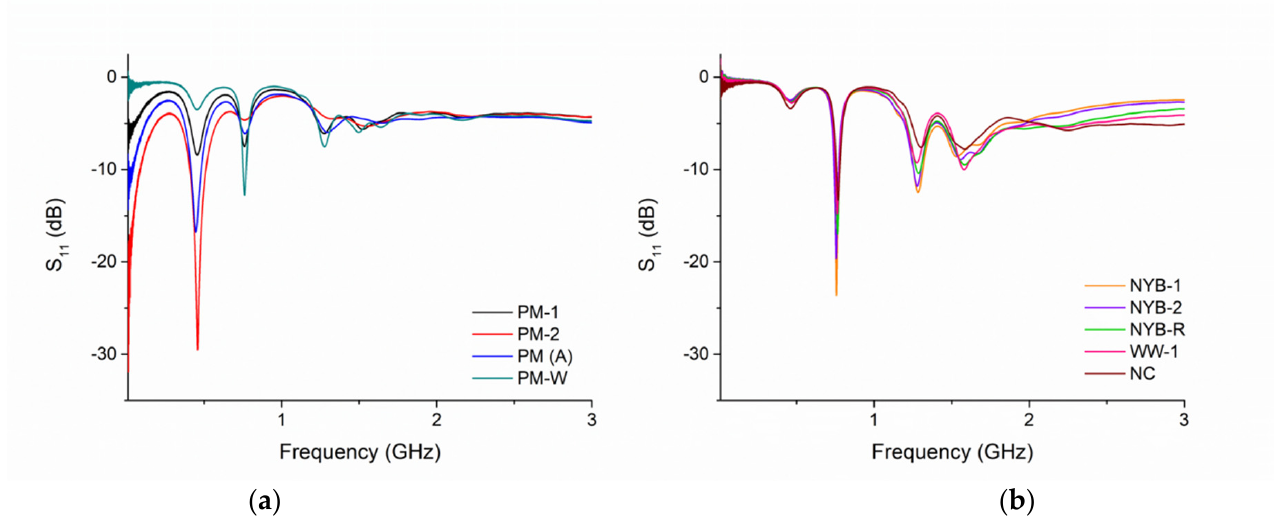
Figure 10. ( a ) Spectral responses captured in the laboratory using a ZVA 24 for samples collected at Parys Mountain ( b ) and in the other three less polluted mining sites, Nant y Mwyn, Leadhills and Wemyss mines.